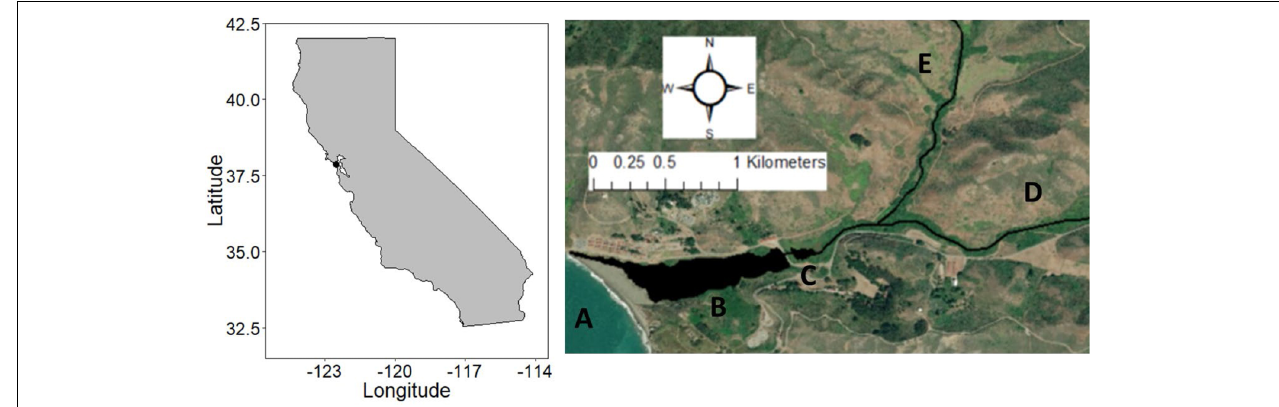
FIGURE 1 | Map of the study area. A = Pacific Ocean. B = Rodeo Lagoon. C = Rodeo Lake. D = Rodeo Creek. E = Gerbode Creek. Imagery source: Esri: DigitalGlobe, GeoEye, EarthStar Geographics, CNES/Airbus DS, USDS, USGS, AeroGRID, IGN, and the GIS User